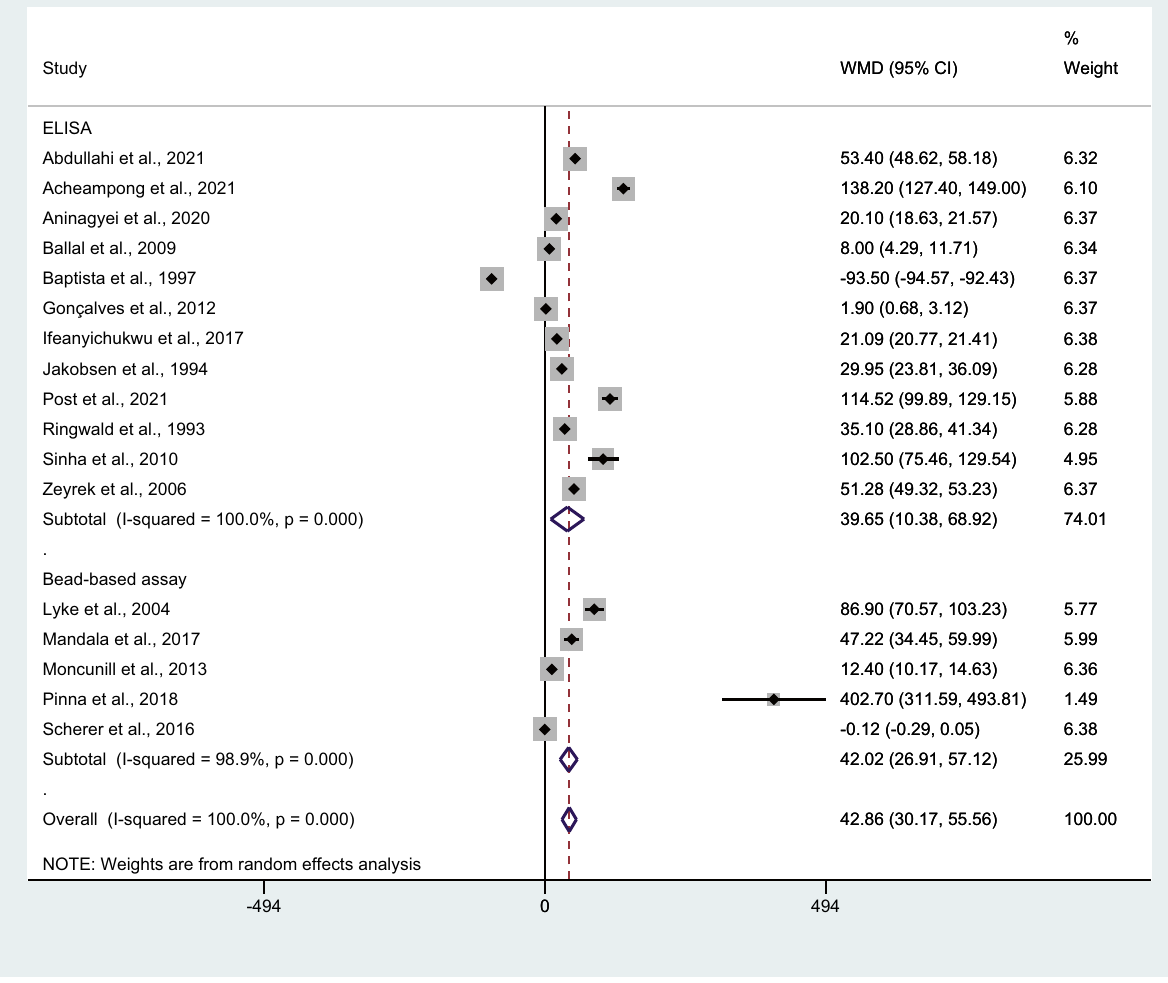
Figure 11. Differences in IL-6 levels between patients with uncomplicated malaria and controls by assays for IL-6. Abbreviation: WMD, weighted mean difference; CI, confidence interval; black diamond symbol, point estimate; solid line in the middle of the graph at 0, zero effect size; Dashed red line: pooled WMD between the two groups; I 2 , level of heterogeneity; P = 0.000 or less than 0.05, significant